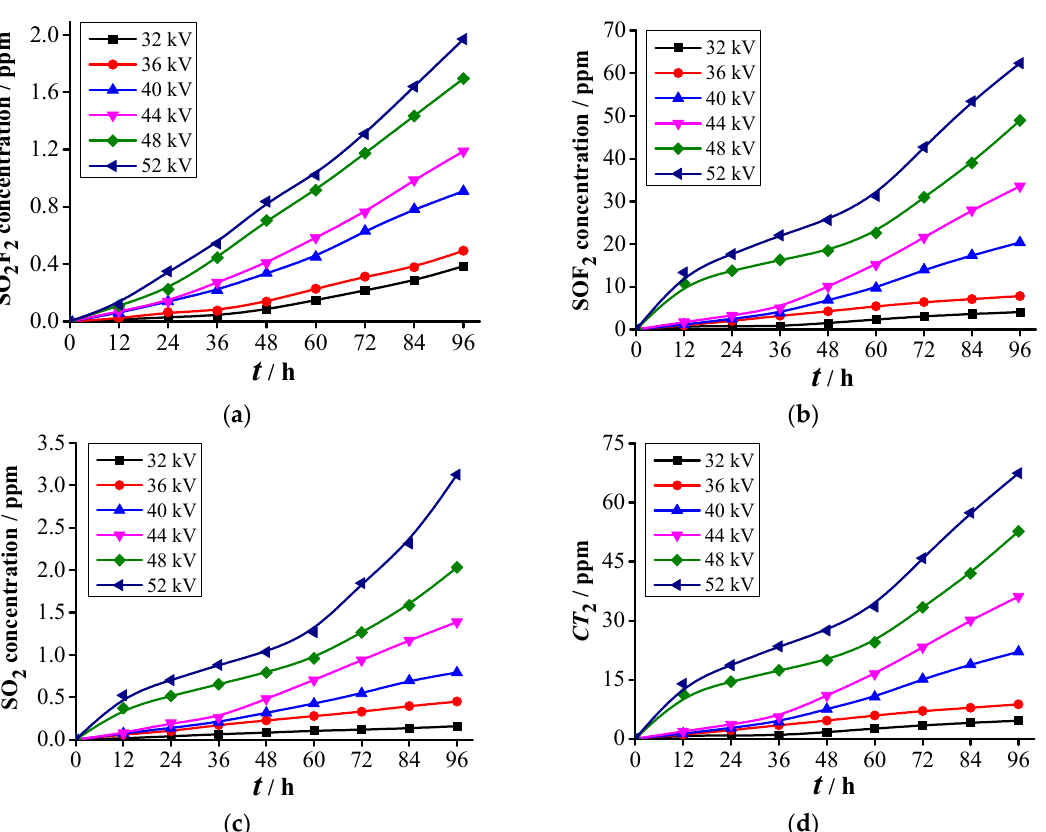
Figure 9. Change of sulfur-containing components with time: ( a ) SO 2 F 2 ; ( b ) SOF 2 ; ( c ) SO 2 ; and ( d ) CT 2 . SOF 2 is mainly generated through the reaction of SF 4 with H 2 O. In the early stage of the experiment ( t ≤ 36 h), when the voltage U ≤ 44 kV, the formation of SF 4 is limited by the PD energy to some extent, thus the SOF 2 concentration increases slowly (Figure 9b). When the voltage U > 44